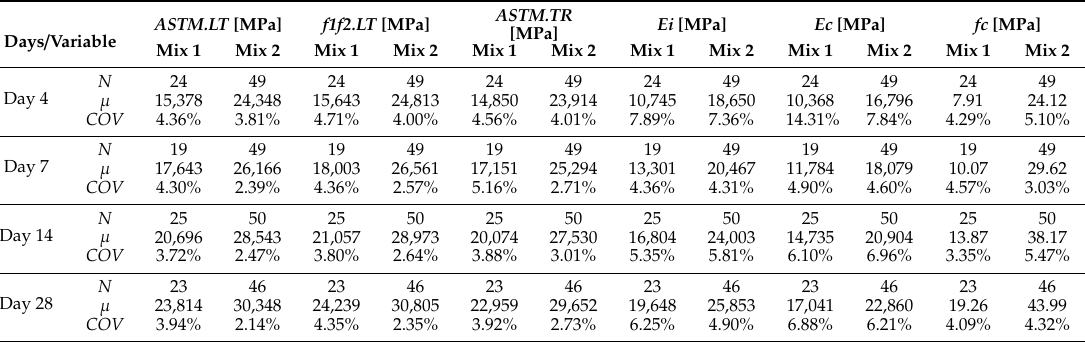
Table 3. Summary of statistical